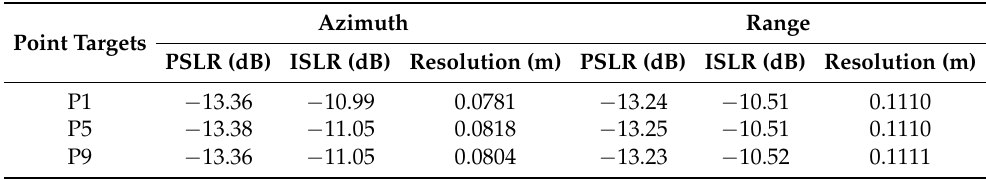
Table 2. Evaluation of Focusing Quality In Point Target’s Simulation.